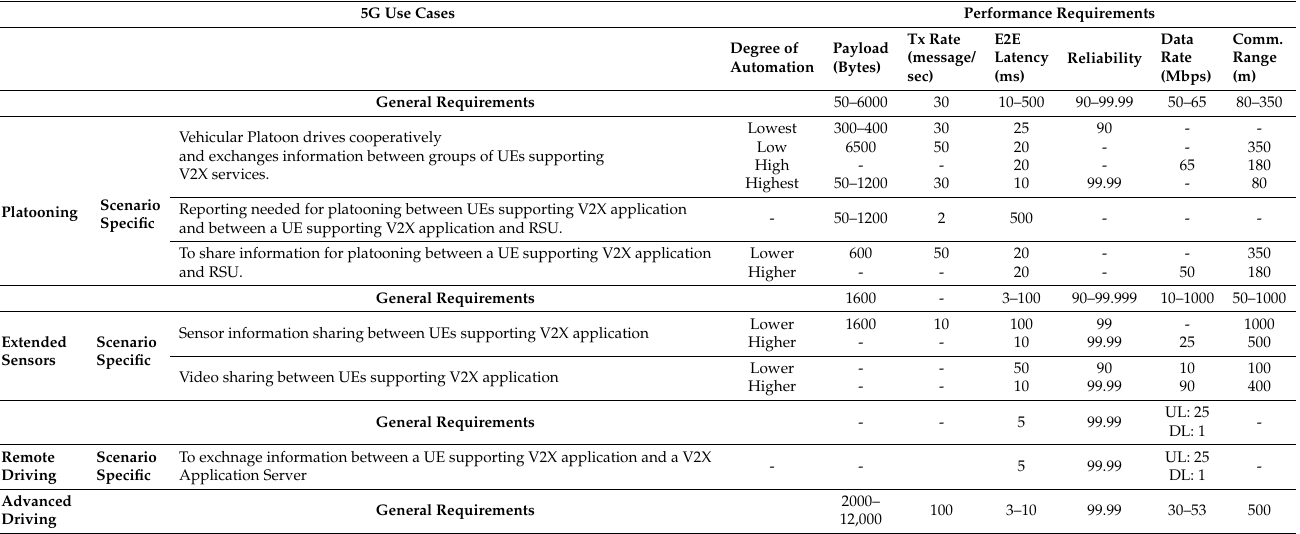
Table 2. General and Scenario-based Performance Requirements to Support Advanced V2X